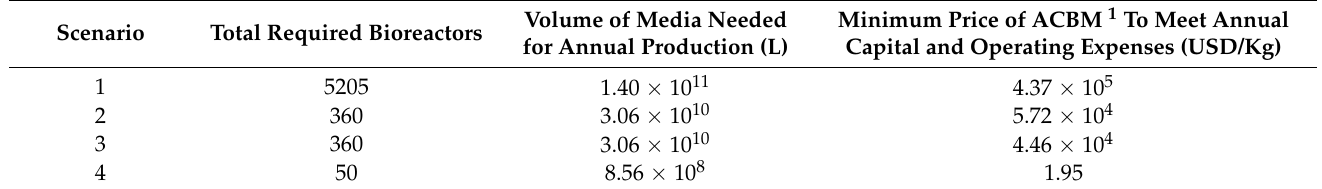
Table 2. Annualized expenditures with quantified drivers of capital and operating